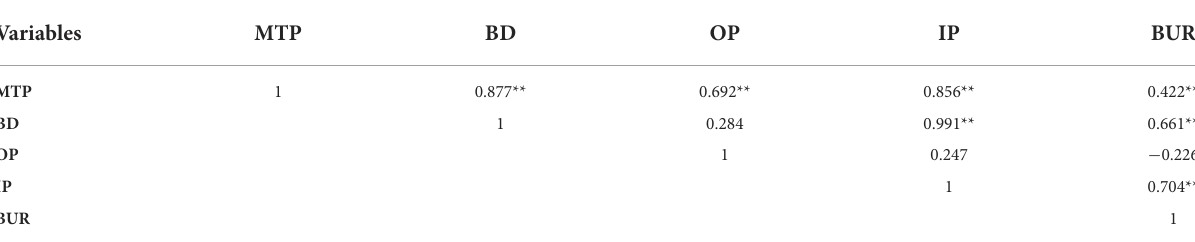
TABLE 2 Correlation coefficient analysis of